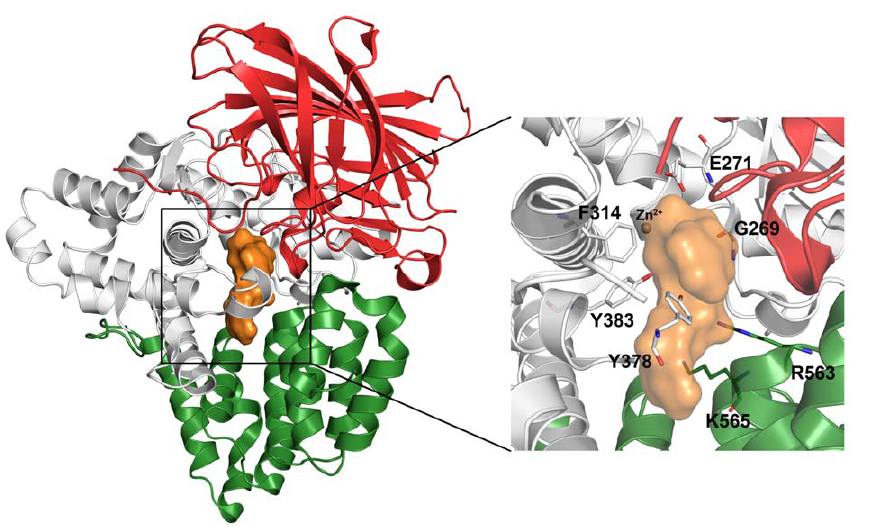
Figure 1. The 3D structure of human LTA4H enzyme. The N-terminal (red), central catalytic (white), and C-terminal (green) domains are shown. The active site located at the center of three domains is occupied with a tripeptide (orange surface). The zoomed view shows the important catalytic residues (sticks) involved in interacting both the substrates. Hydrogen atoms are hidden for a clear view.